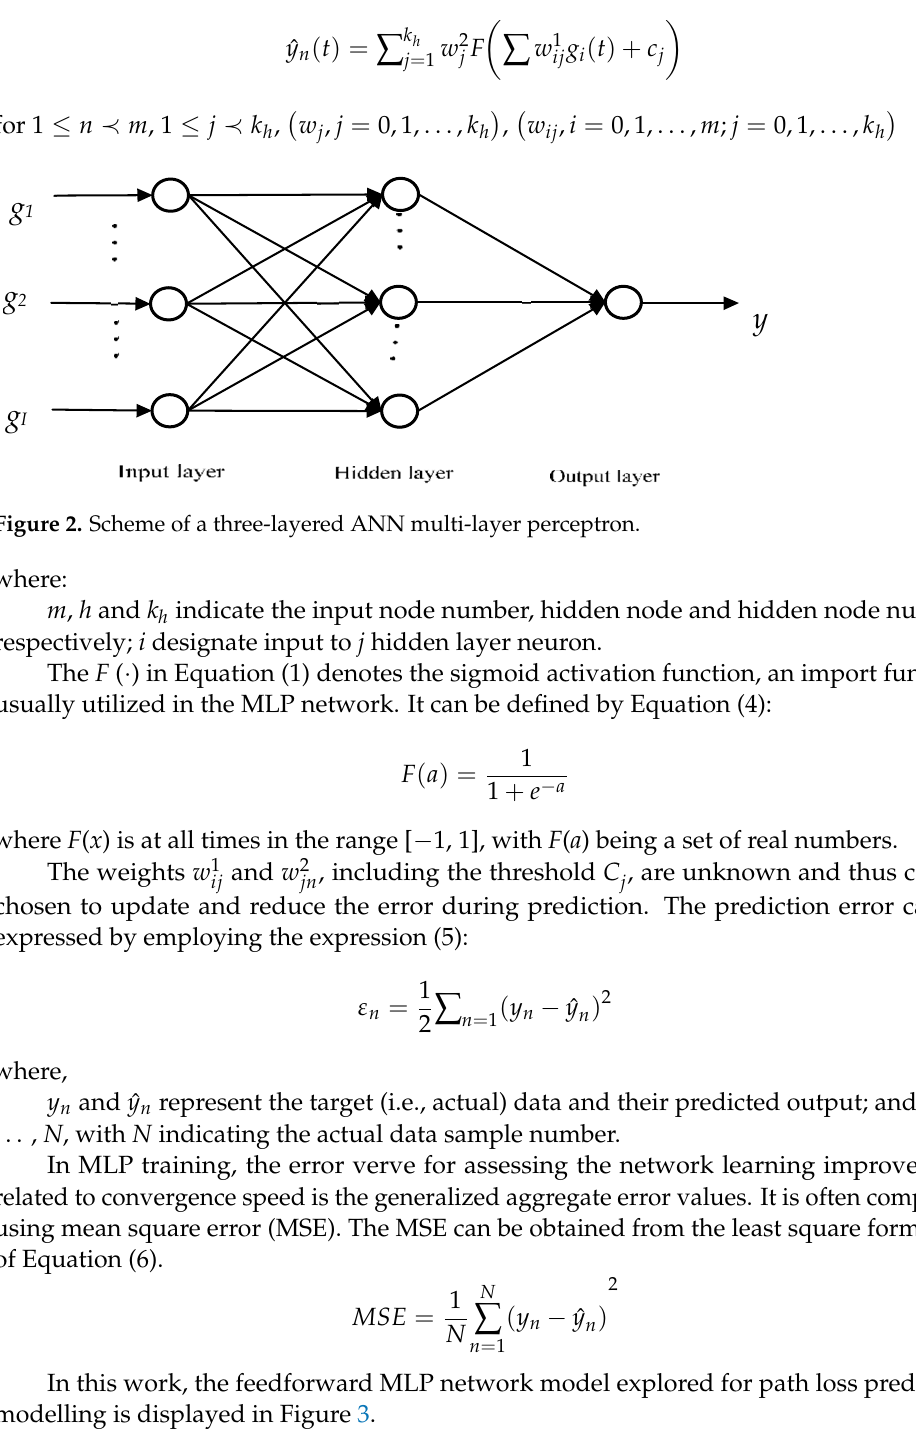
Figure 3. ANN MLP Model Structure for Path Loss Prediction.